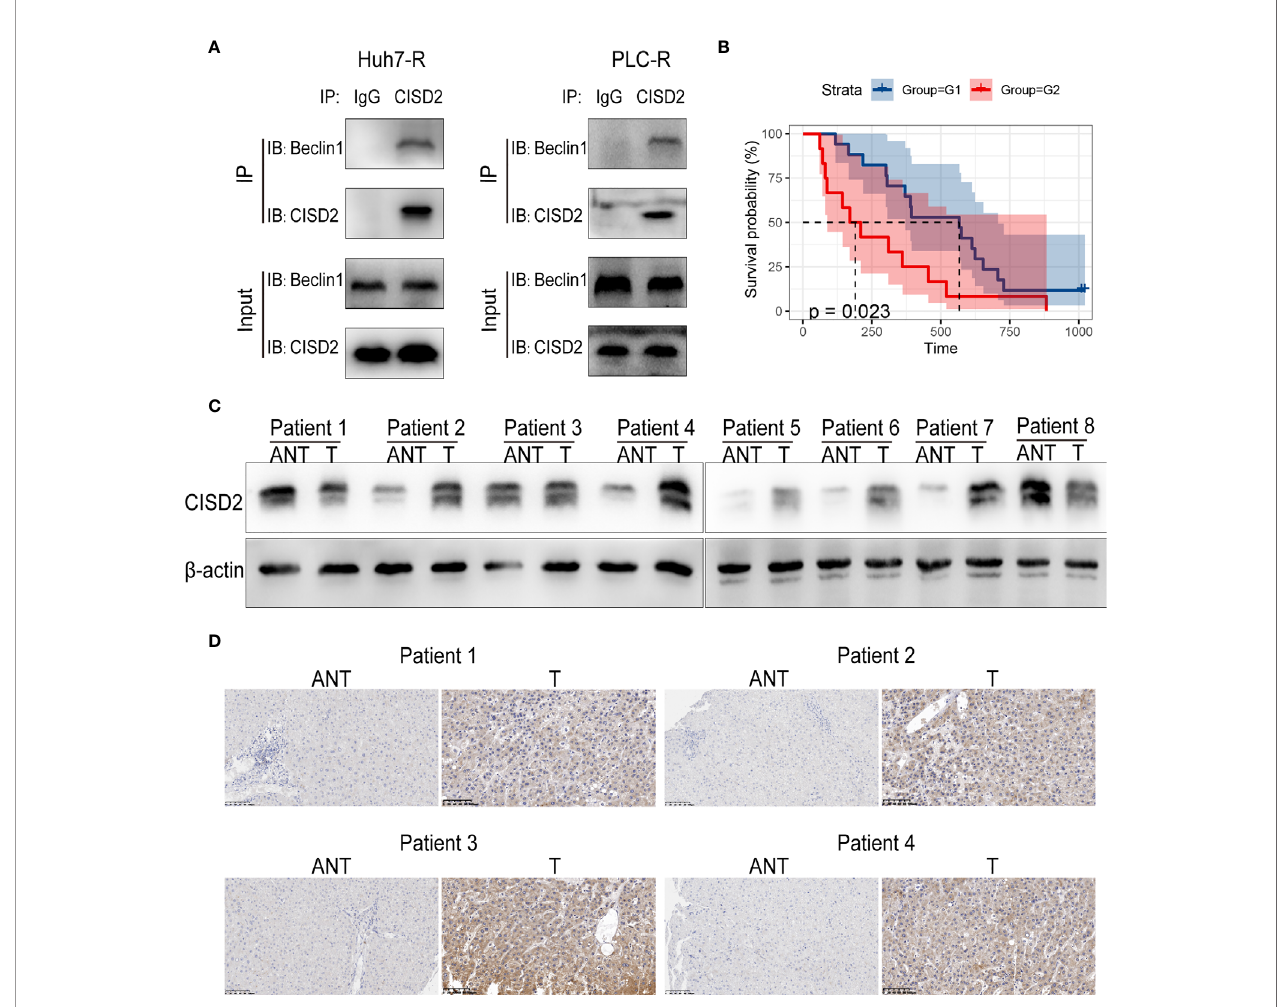
FIGURE 8 | Correlation between CISD2 expression and the survival of HCC patients. (A) Co-immunoprecipitation of endogenous CISD2 and Beclin1 in HCC resistant cells. (B) Correlation between CISD2 expression and survival analysis of HCC patients (G1=CISD2 low expression group, G2=CISD2 high expression group). (C) Western blot was used to detect the expression level of CISD2 in HCC tissues (T) and adjacent normal tissues (ANT). (D) Immunohistochemistry was used to detect the expression level of CISD2 in HCC tissues and adjacent normal